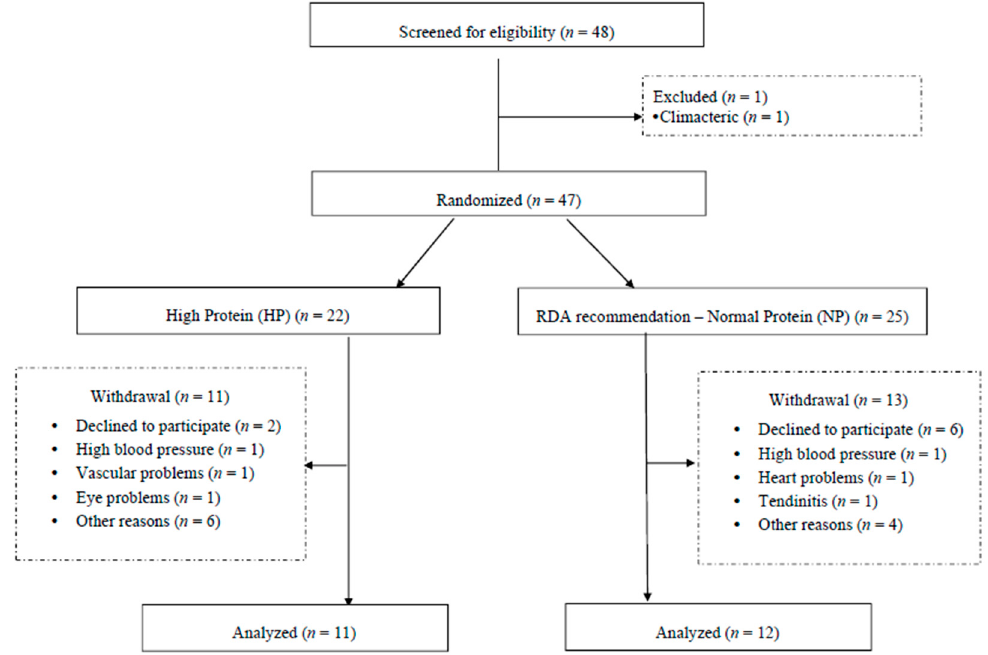
Figure 1. Randomization of the individuals in the study.